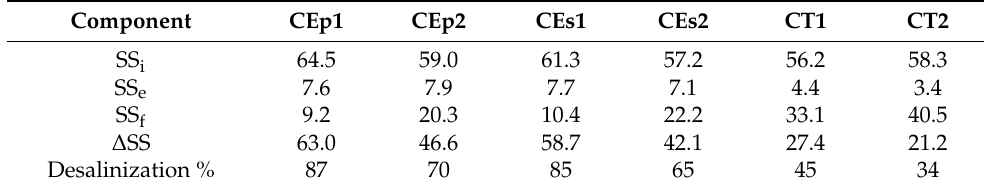
Table 5. Soil salt balance established at the end of the experiment between the initial salt stock (SSi), salt supplied by irrigation water (SSe) and the final salt stock (SSf) in the six columns. CT1 and CT2 are the columns with bare soil. CEs1 and CEs2 are the columns cultivated with seasonal E. stagnina and CEp1 and CEp2 are the columns cultivated permanently with E. stagnina . Component CEp1